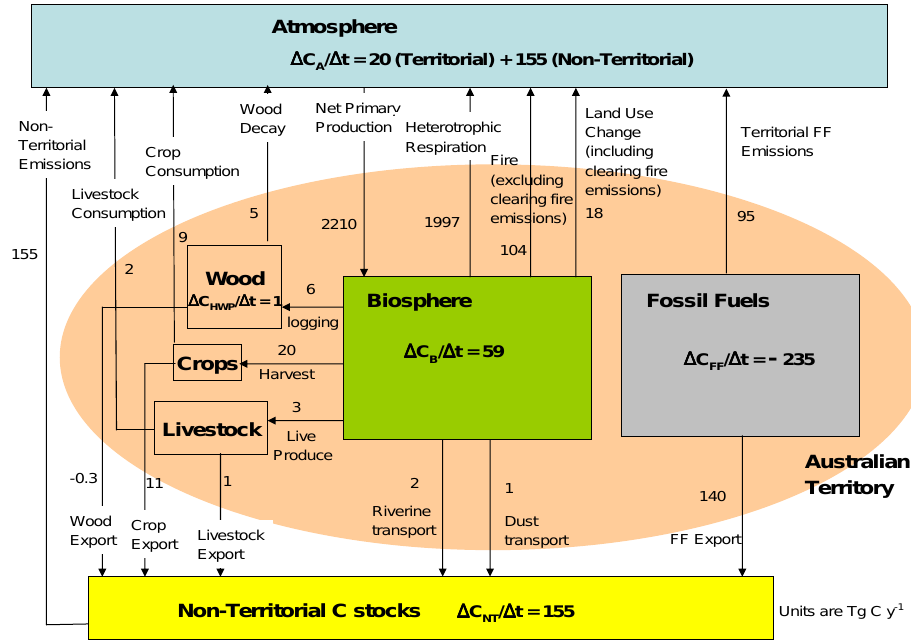
Figure 1. Summary of the Australian Territorial Carbon Budget, 1990–2011.